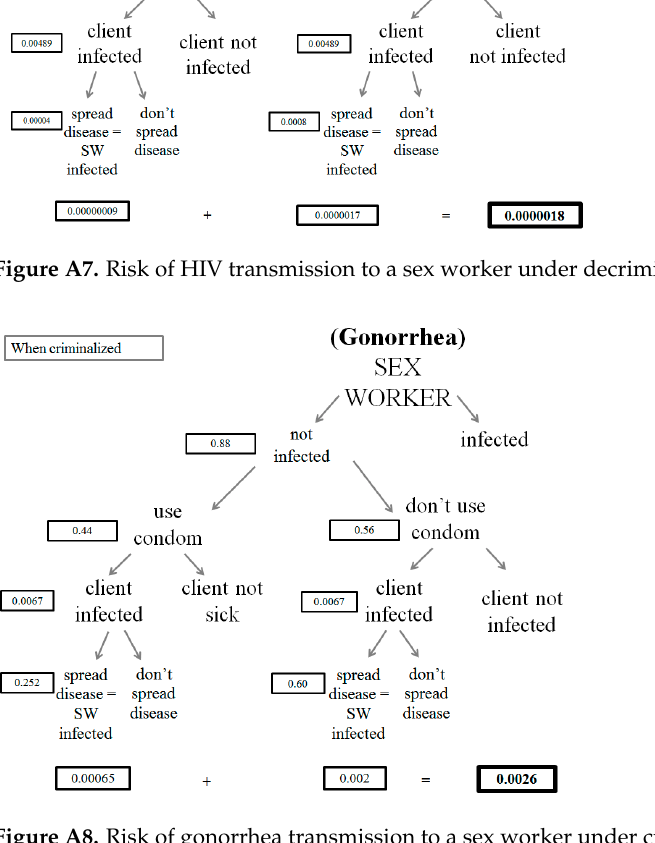
Figure A8. Risk of gonorrhea transmission to a sex worker under criminalization.